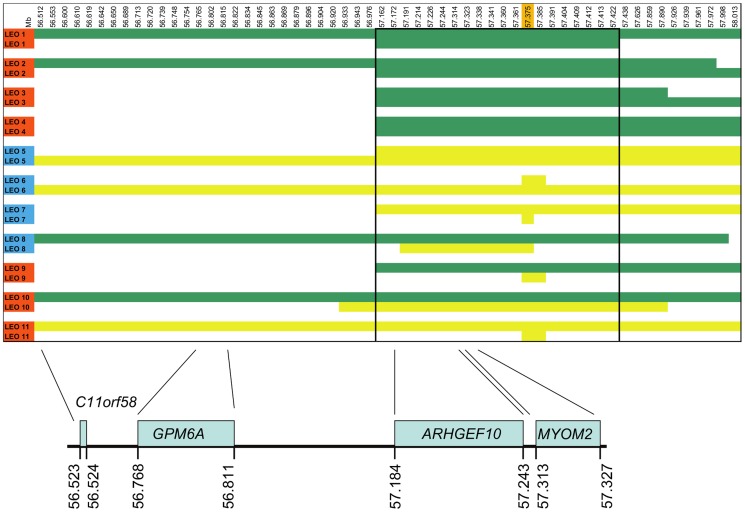
SNP haplotypes and genes from the GWAS identified CFA16 region associated with Leonberger PN.A representative sample of the observed CFA16 haplotypes is demonstrated using eleven Leonbergers, with both haplotypes shown for each dog as green or yellow bars. LEO 1-4 and LEO 9 - 11 are cases (indicated in red), while LEO 5-8 are controls (indicated in blue). The most significantly associated SNP (BICF2G630820235) is highlighted in orange. Green bars represent the most significantly associated haplotype, which, in some cases extended the entire 1.5 Mb region. However, a minimum associated haplotype of approximately 250 kb (enclosed in the dark outlined box) was observed. An alternate haplotype, demonstrated by the yellow bars, was present in many of the controls and some of the cases. Some PN cases (LEO 9-11) are either heterozygous or devoid of the “green” case-associated haplotype and a phenotypically normal dog (LEO 8) is heterozygous for the associated haplotype. CFA16 (Mb, CanFam2) ENSEMBL-annotated genes in the region are shown at the bottom of the figure.